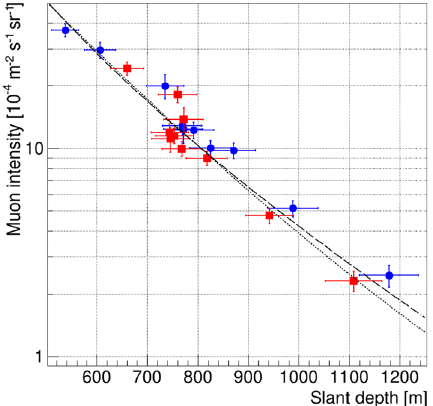
Fig. 8 Muon intensity as a function of slant depth. The blue circles were measured at LAB2400 and the red squares, at LAB2500. The error bars represent 5% uncertainty in the projected thickness determination from the satellite data and the 4% systematic error of the measured intensity. The best fit using (1) yielded the average rock density of 2 . 67 g / cm 3 (dashedcurve),while(2)yielded2 . 73 g / cm 3 (dottedcurve)